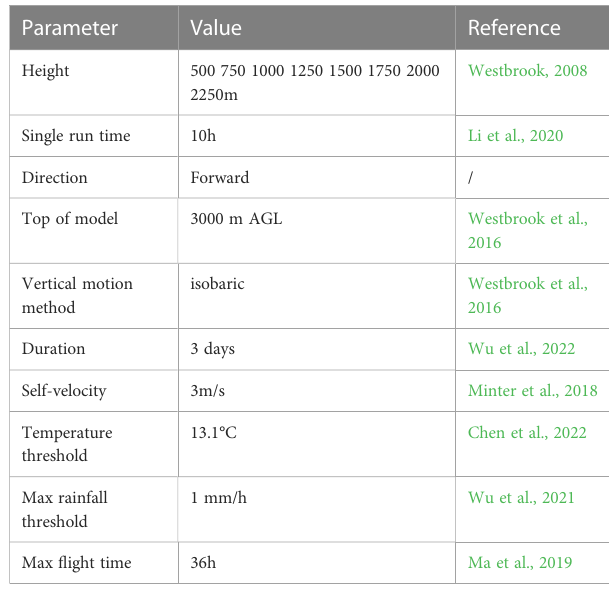
TABLE 2 Parameters used for simulating FAW